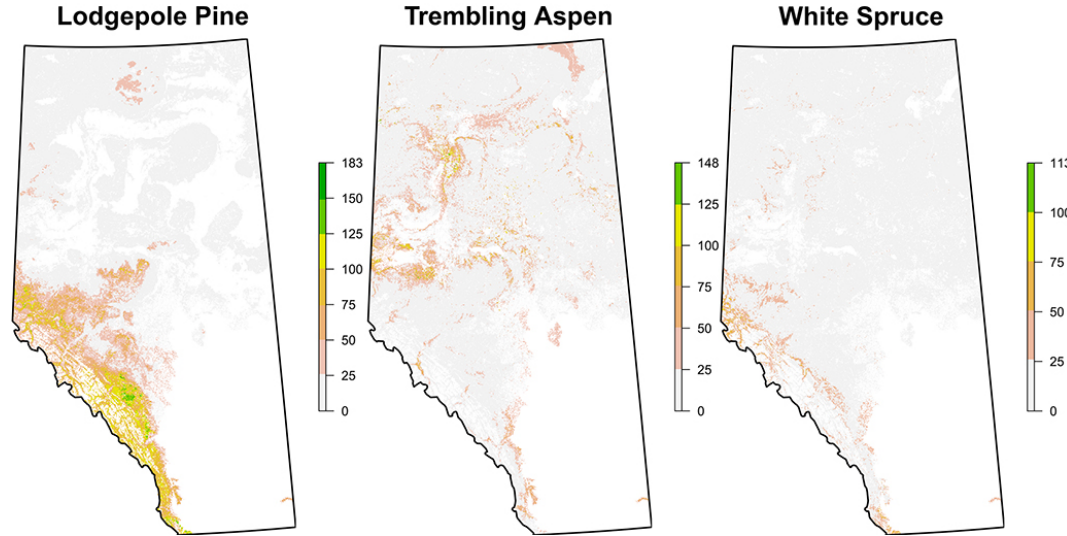
Figure 5. Total tree AGB density (Mgha − 1 ) of three major tree species based on decision-tree-based modeling (Projection: UTM zone = 11; spatial resolution: 1km). Table 4. Total tree biomass of three major tree species estimated by decision-tree-based approach. Species Natural regions Summary based on Summary based on